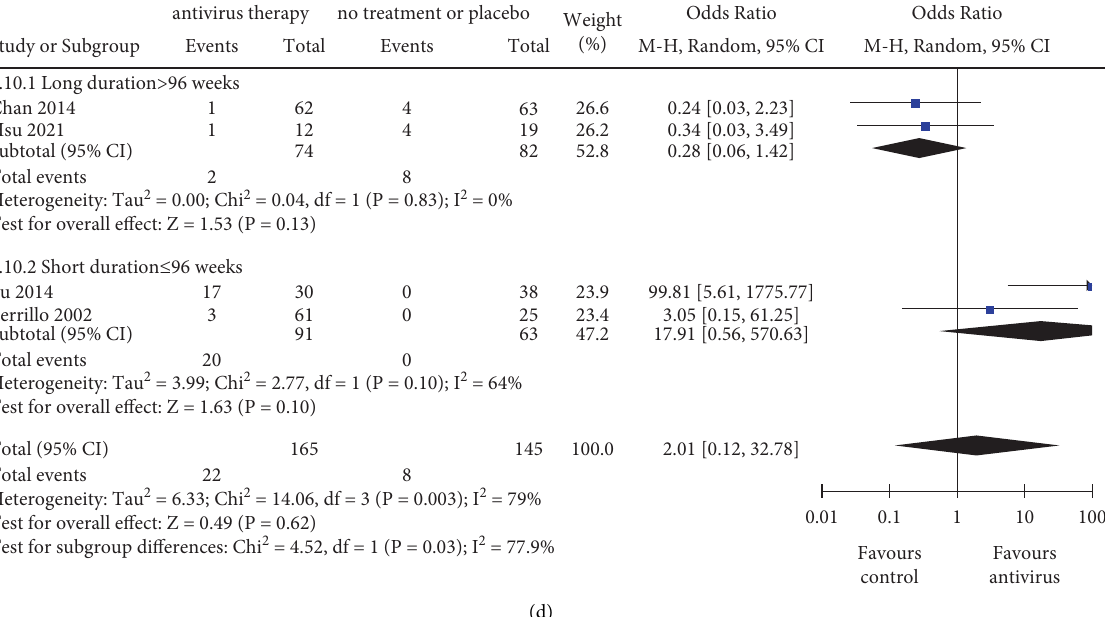
Tau 2 = 0.00; Chi 2 = 0.04, df = 1 (P = 0.83); I 2 = 0% Test for overall efect: Z = 1.53 (P = 0.13)